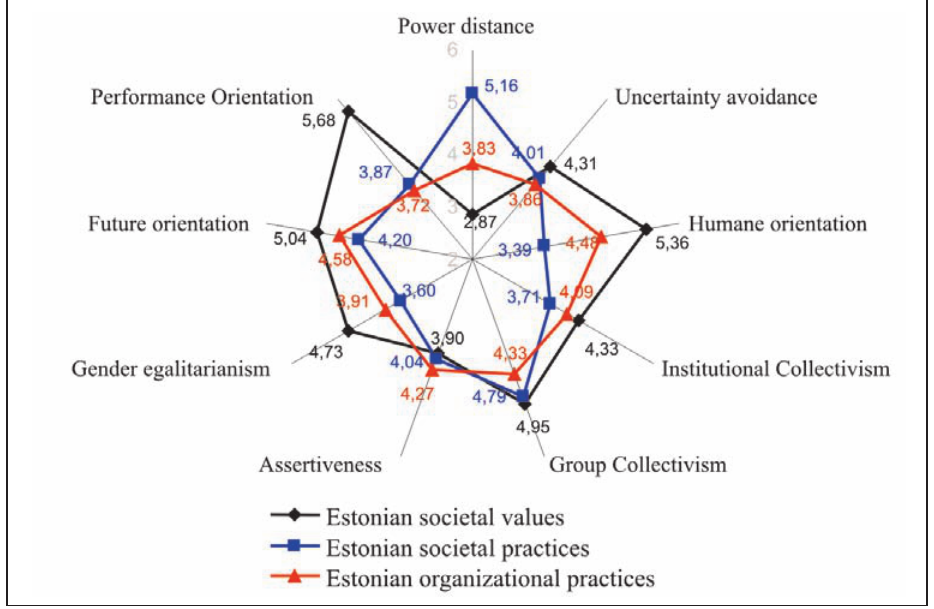
Fig 4. Finnish societal values compared to Estonian societal and organizational